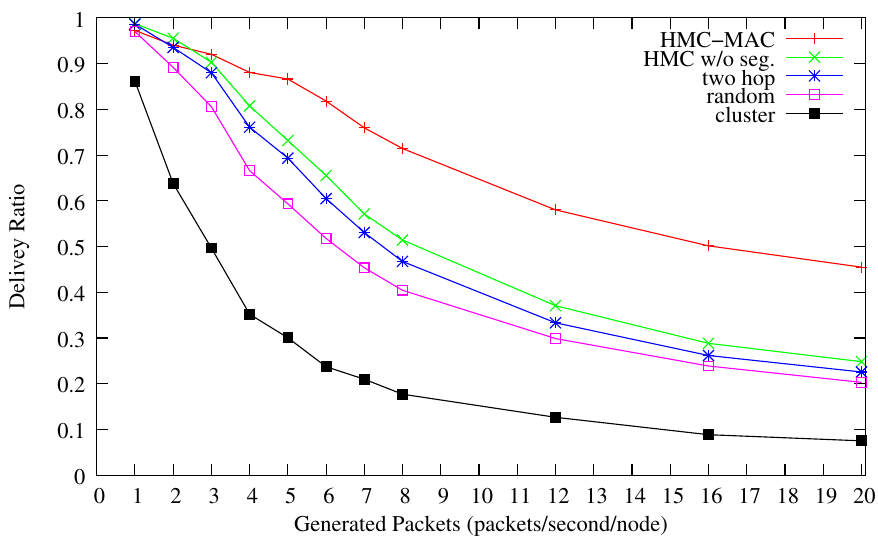
Figure 10. Delivery ratio at the sink for burst traffic.